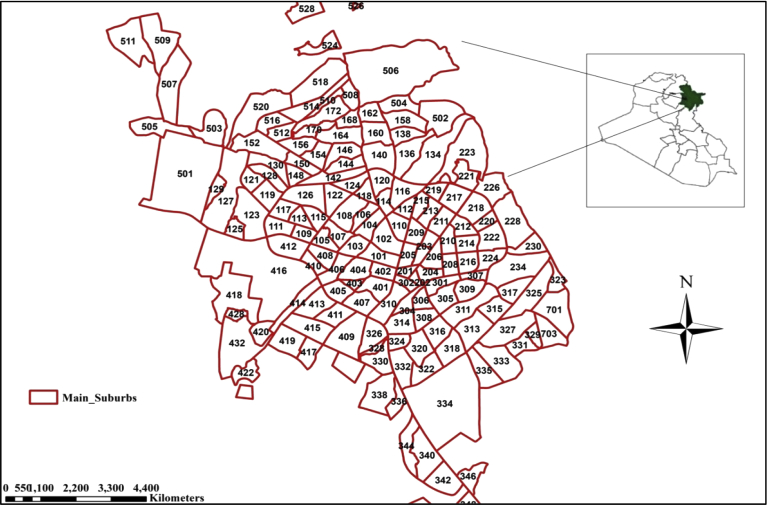
The districts of the study area (Sulaimani Municipality, 2017).